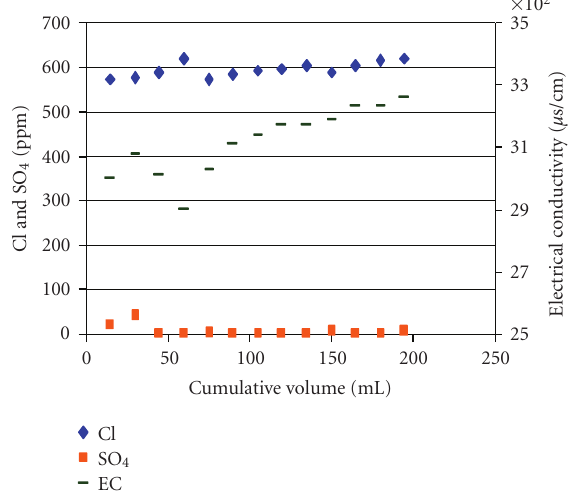
Figure 13: Breakthrough results for prepared ion exchanger using groundwater